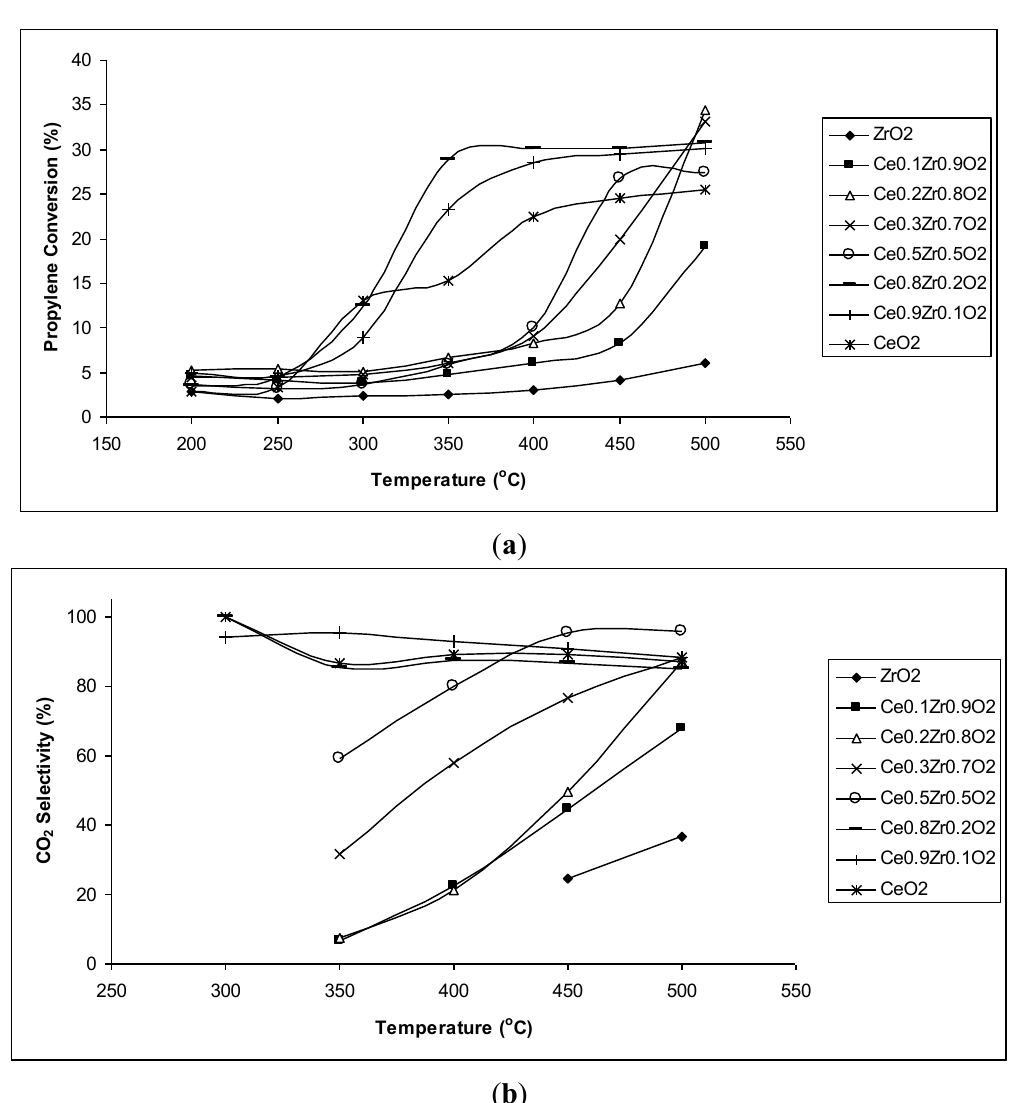
Figure 2. ( a ) Propylene conversion (%) and ( b ) CO 2 selectivity (%) of CeO 2 –ZrO 2 chemical mixtures at different reaction